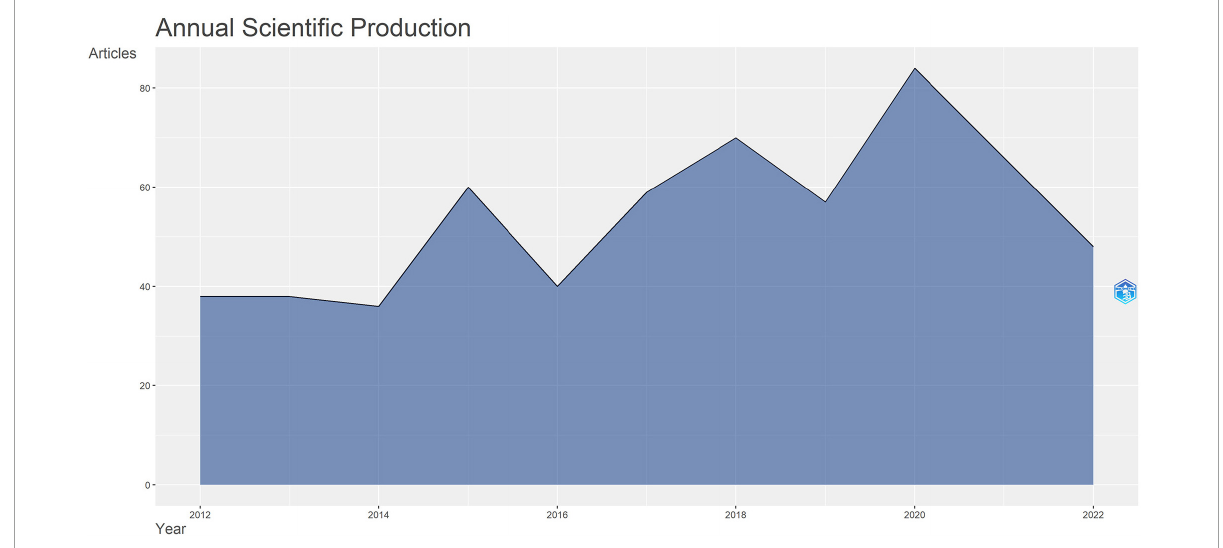
FIGURE1 Annual article output of paper citations between 2012 and 2022 in this research area.